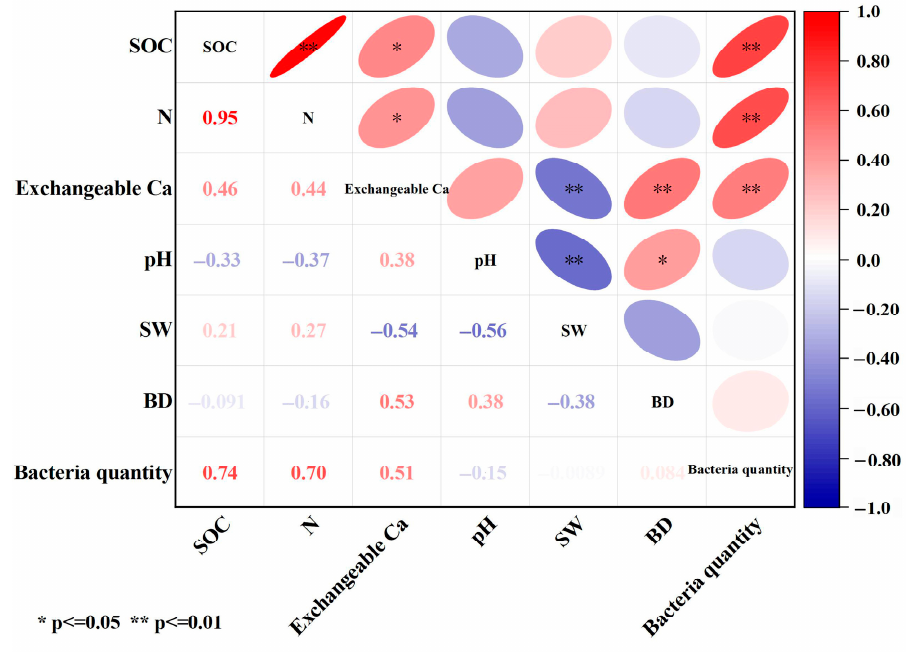
Figure 7. Spearman’s correlations among all measured soil properties. SOC—soil organic carbon; N—nitrogen; SW—soil water; BD—bulk density.